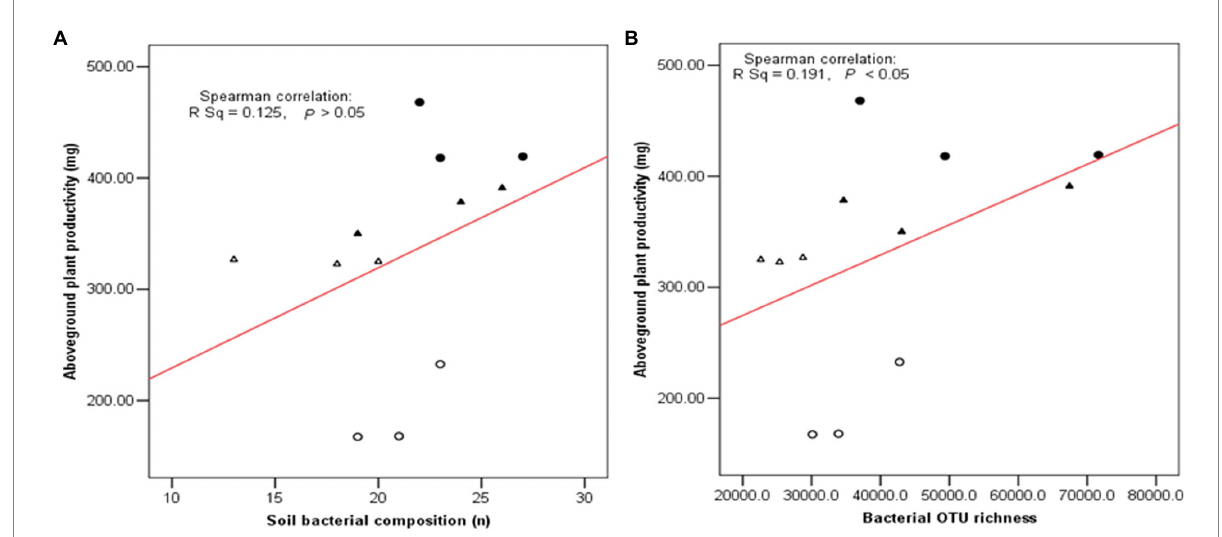
FIGURE 8 Relationship between plant biomass and soil bacterial composition (A) and bacterial OTU richness (B) in soil. Filled triangle ( ▲ ) and Triangle ( ∆ ) indicated the inoculation with NG-33 and non-inoculation in the sand soil with supplement of TCP, and filled cycle ( ● ) and cycle ( ○ ) indicated the inoculation with NG-33 and non-culation in the loamy